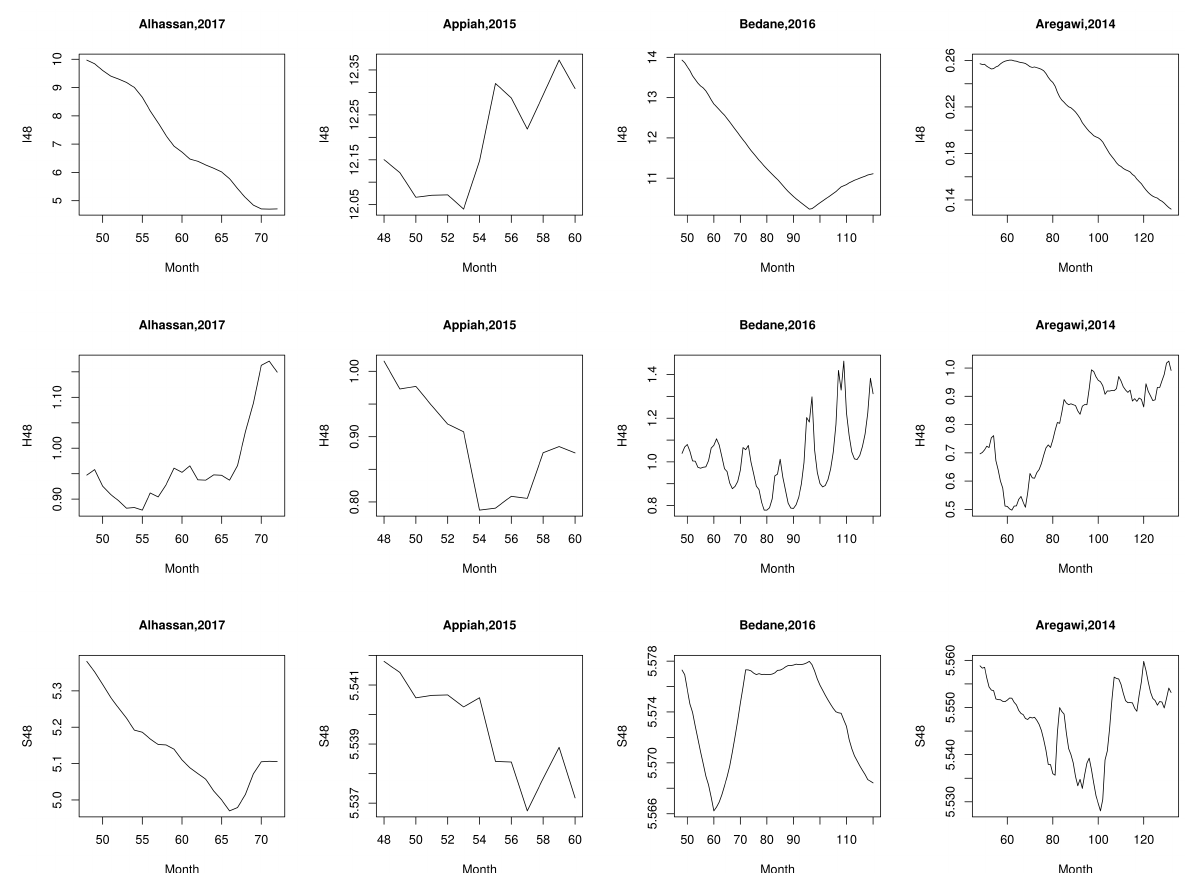
Figure A6. (Cont. Figure A5): Gomez-Elipe et al. (Karuzi in Burundi, 2007) [24], Muwanika et al. (Uganda, 2017) [26], Landoh et al. (Est Mono district in Togo, 2012) [25], and Okech et al. (Kenya, 2008)